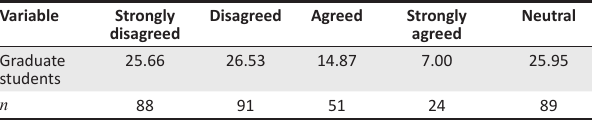
TABLE 4b: Does knowledge of NC facilitate the learning of